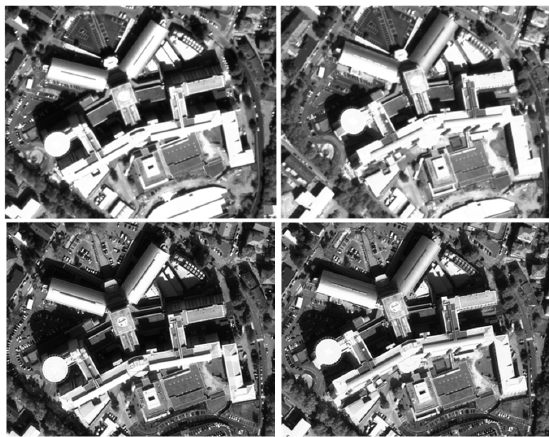
Figure 2. Zoom in the stereo satellite images on the same building block. [Top] WV2 forward-looking (left) and backward-viewing (right) images. [Bottom] GE1 forward (left) and backward (right) images.